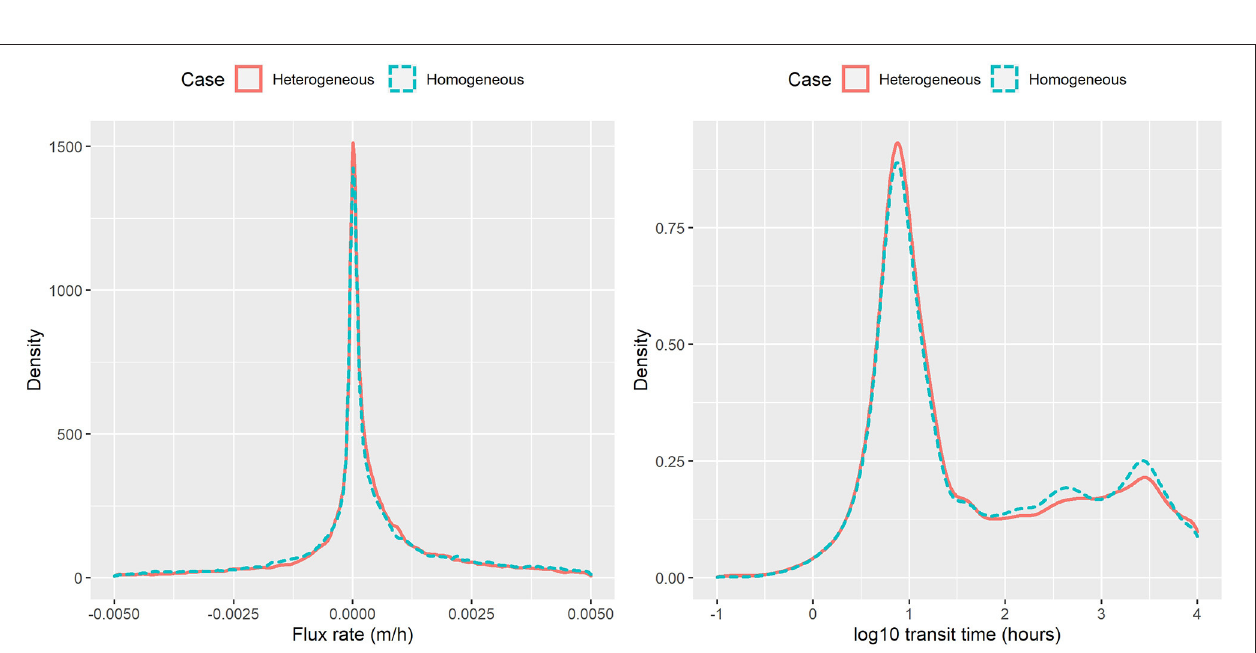
FIGURE 10 | Flux rate and transit time obtained from particle tracking for homogeneous and heterogeneous cases.